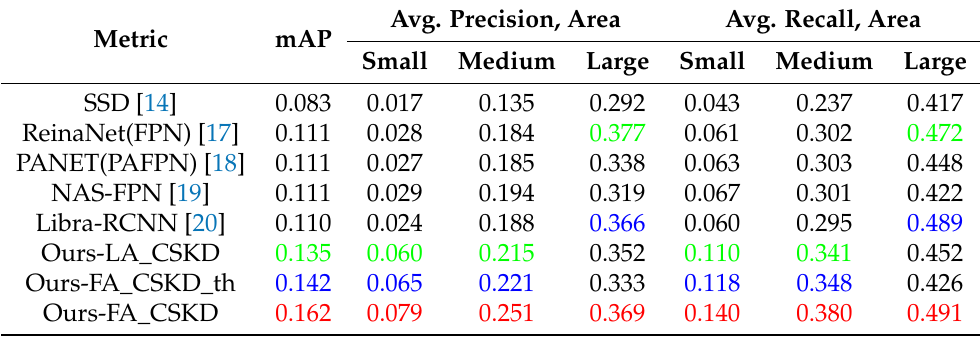
Table 4. Compare with the SOTA methods. The top three methods are highlighted in red, blue, and green.